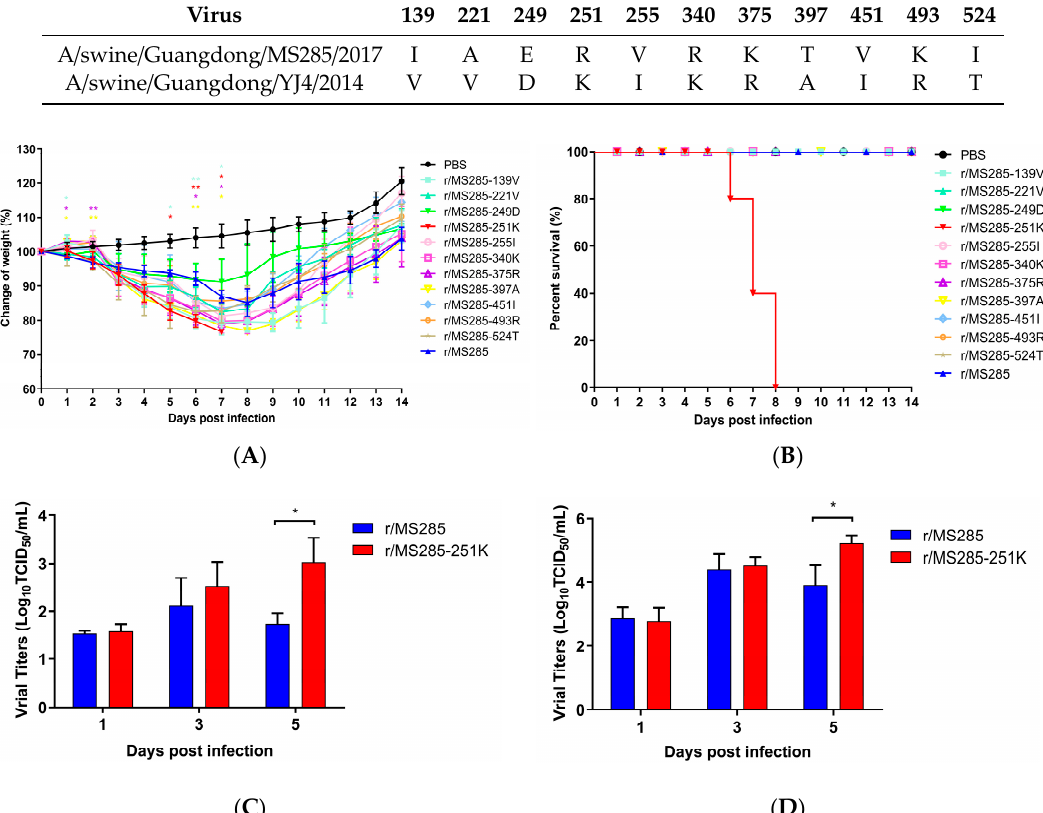
Figure 3. Weight changes, mortality, and replication of MS285 mutants in mice. Six-week-old female BALB / c mice were inoculated intranasally with 10 6 TCID 50 of reassortant viruses containing single amino acid mutations. The body weight change rate ( A ) and survival rate ( B ) in the infected mice were continuously recorded for 14 days. Mice with weight loss of more than 25% of their initial body weight were euthanized humanely. The average body weight change rates in each group are displayed with error bars representing the standard deviations (±). Significant body weight changes of the mutant virus-inoculated mice compared with r/MS285 virus-inoculated mice (*, p < 0.05; **, p < 0.01). Replication efficiency of viruses in the nasal turbinate ( C ) and lungs ( D ) of infected mice. At 1, 3, and 5 days post-infection (dpi) with 10 6 TCID 50 of r/MS285 and r/MS285-251K viruses three mice were euthanized to collect the nasal turbinate and lungs. Virus replication was determined by TCID 50 assay in MDCK cells.